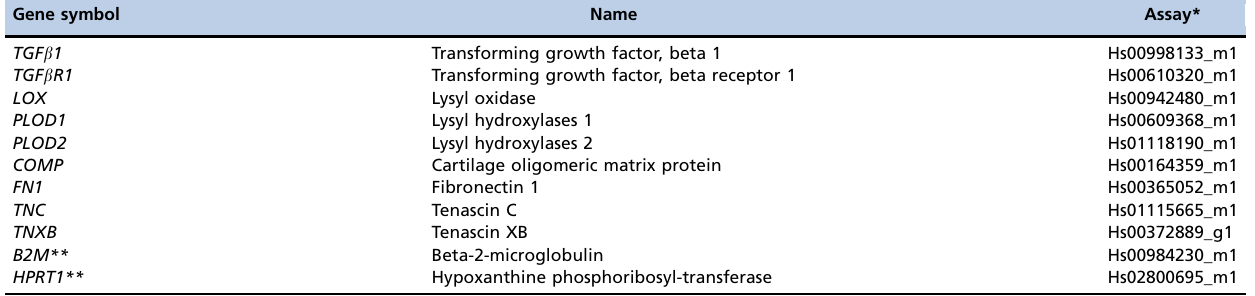
Table 2 - Summary of reference gene and target gene assays. Gene symbol